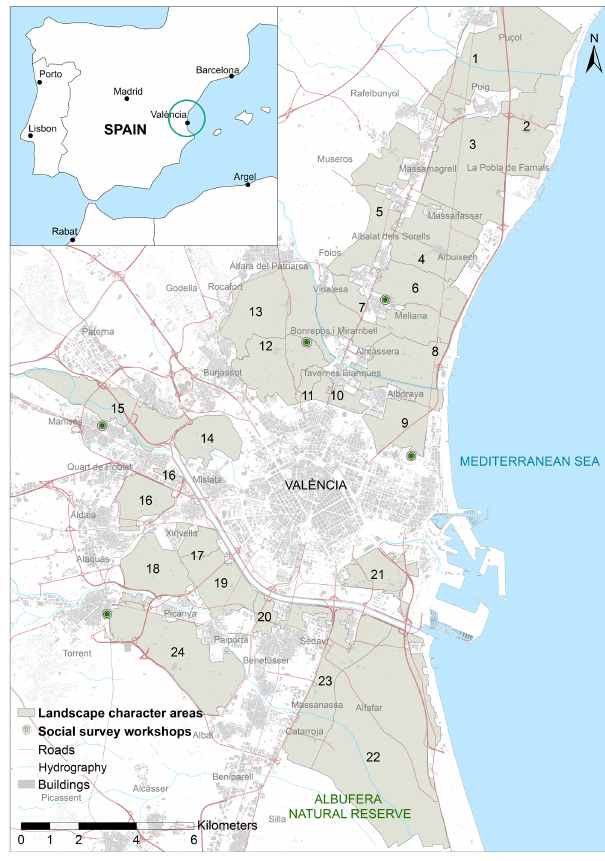
Fig. 1. Map of the study area location, landscape character areas in Huerta de Valencia with their corresponding codes, and sampling points for the social